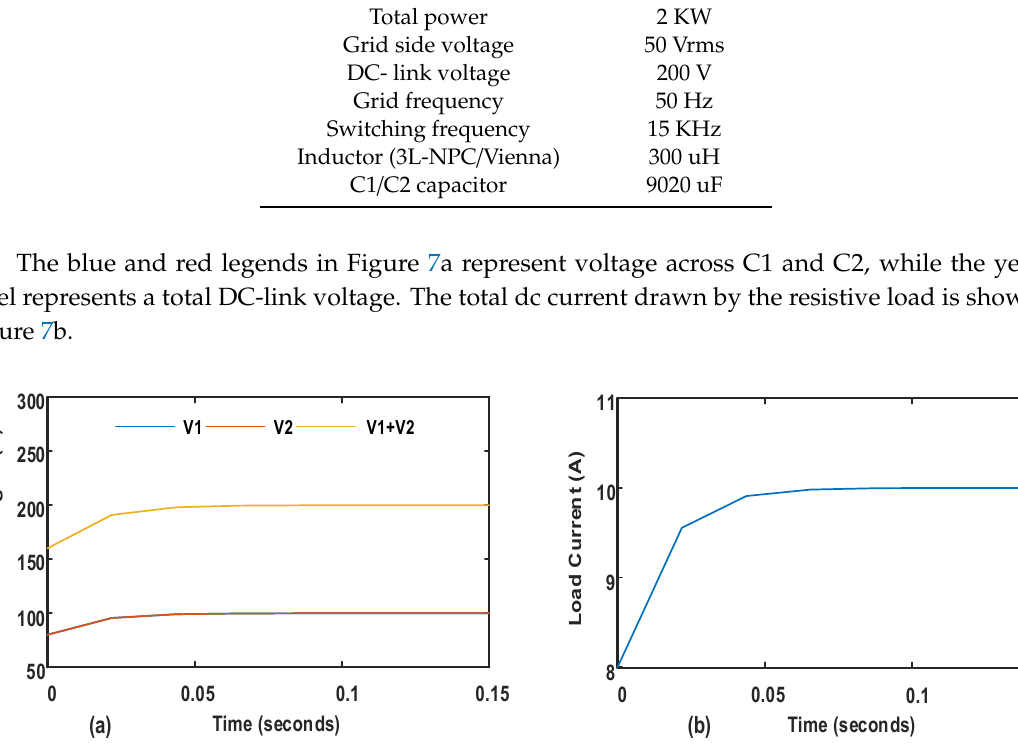
Figure 7. Simulation results of DC link voltage control and load current.